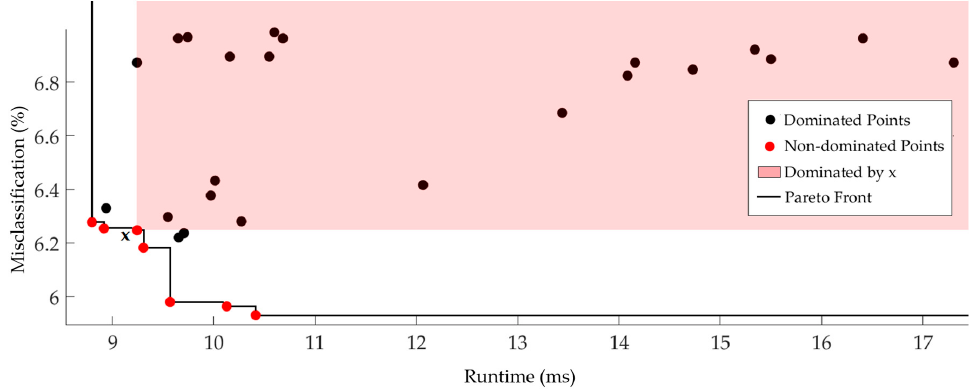
Figure 8. Illustration of some Pareto fronts when minimizing two objectives (misclassification and classification runtime) according to the obtained results in the waist.